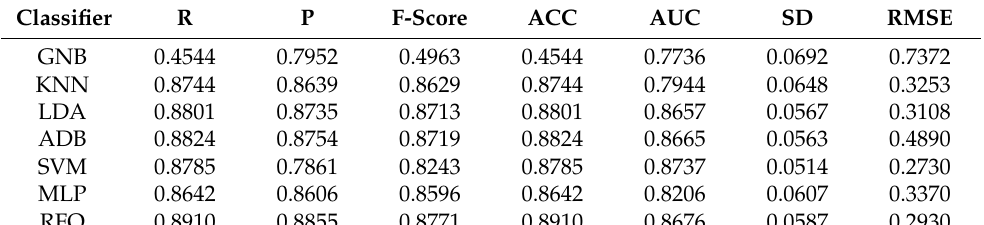
Table 4. Compartment prediction performance using various genomic marks of RNA Pol II loops for various classifiers (all 428 features are considered for classification).